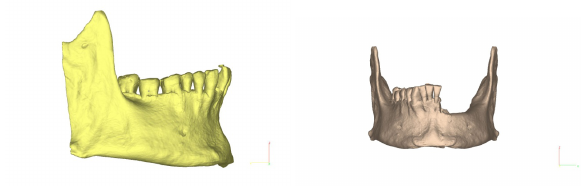
Figure 10. Final view of mandible fragment (a left) and reconstruction of the whole mandible (b right))